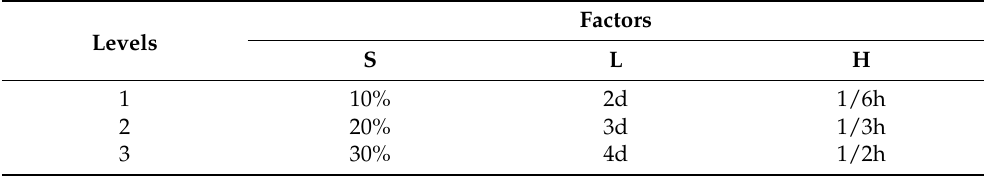
Table 1. Experimental variables with values and levels.